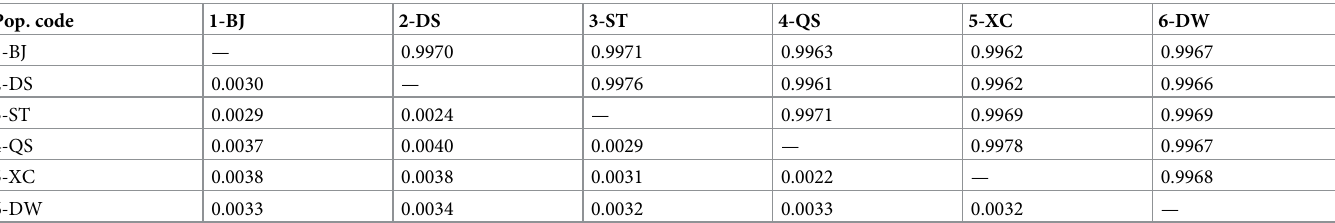
Table 4. Nei’s genetic identity (above diagonal) and genetic distance (below diagonal) of the six populations of Spartina alterniflora in Guangxi. Pop.